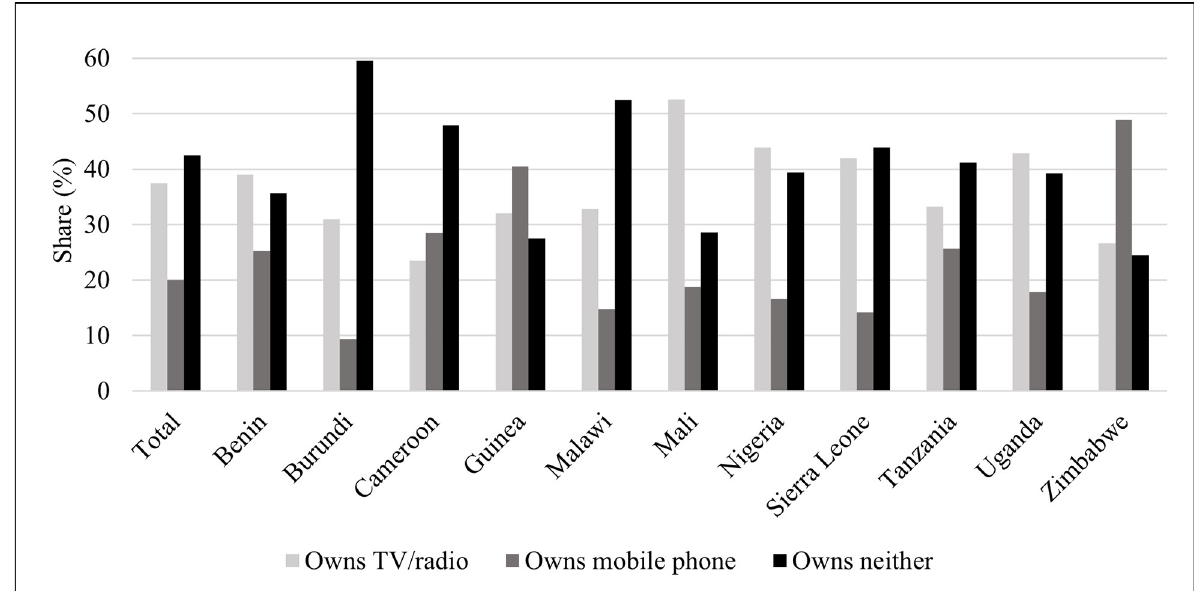
Fig 1. Prevalence of communication means among